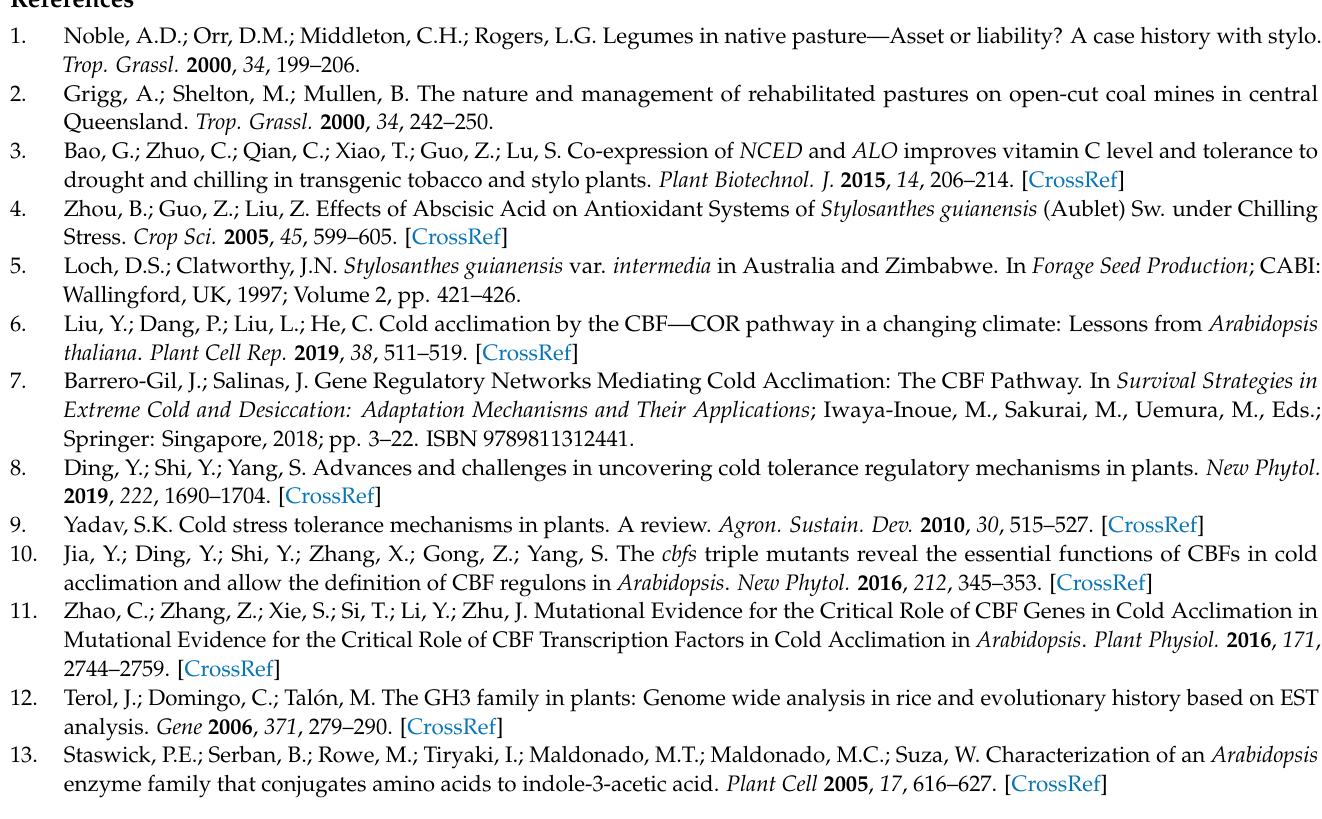
Table S3: The information of the 14 legume GH3.1 proteins used for multiple sequence alignment and phylogenetic tree construction, Figure S1: The growth of fine-stem stylo ( Stylosanthes guianensis var. intermedia ) and S. guianensis cv. Graham before and after winter in Guangzhou, China, Figure S2: PCR amplification of bar (A) and SgGH3.1 (B) genes from wild-type (WT) and SgGH3.1 overexpressing (OE1, 3 and 4) Arabidopsis thaliana , Figure S3: The growth of WT and SgGH3.1 overexpressing (OE1, 3 and 4) Arabidopsis thaliana after 18 days’ cultivation in MS medium supplemented with different concentration of